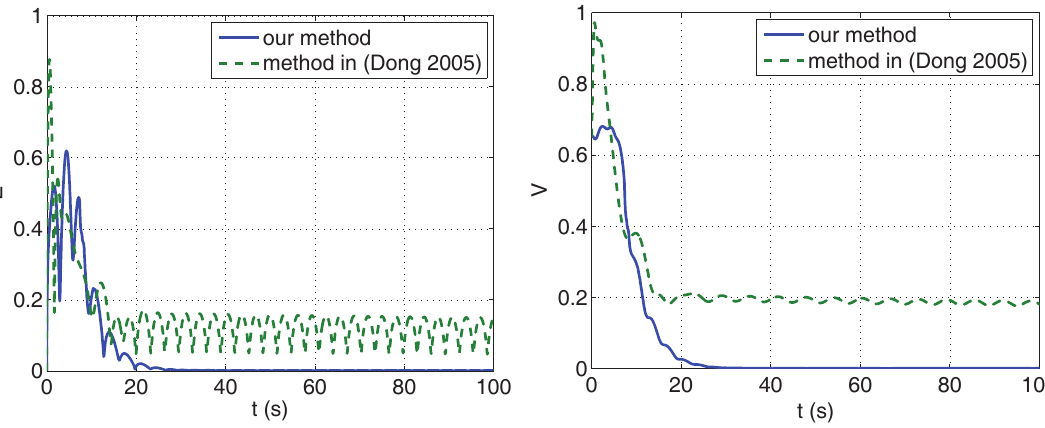
Figure 5. Comparison of the speed performance E and states convergence performance W of this paper and